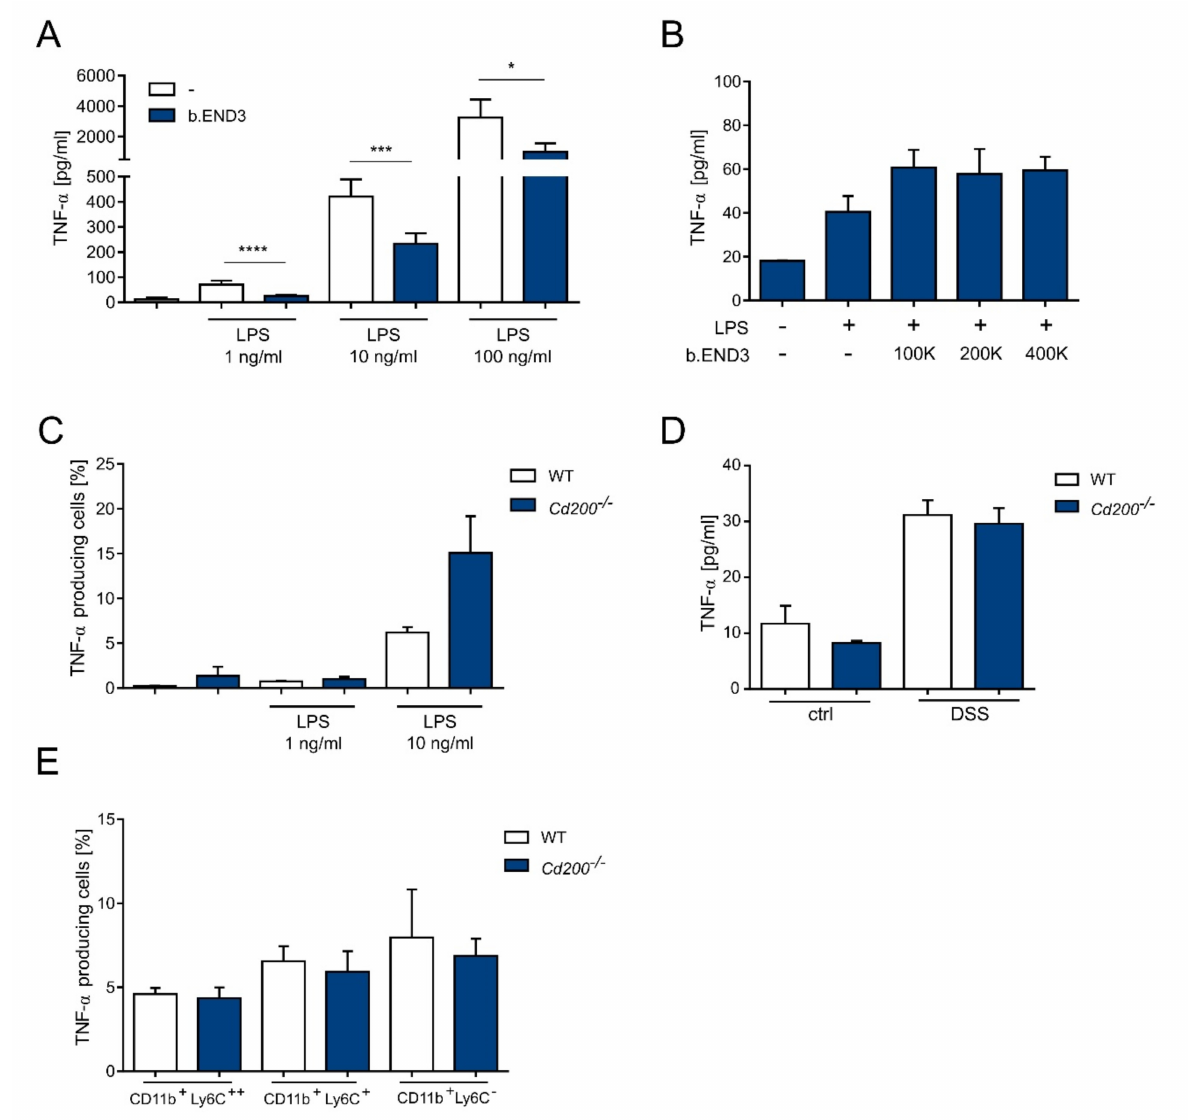
Figure 6. Production of TNF- α by BMDMs and colon tissue in the presence or absence of CD200 expression. ( A ) The concentration of TNF- α was measured in the supernatants from the co-culture of WT BMDMs and b.END3 cells after 24 h of incubation with or without 1–100 ng/mL LPS, n = 4–6; ( B ) The concentration of TNF- α was measured in the supernatants from 24-h co-cultures of WT BMDMs and indicated a number of b.END3 cells with or without 1 ng/mL of LPS without direct contact of two populations (Transwell system), n = 2–3; ( C ) Percentage of TNF- α + WT or Cd200 − / − BMDMs after 4 h incubation with 1 or 10 ng/mL LPS, n = 3. ( D ) The concentration of TNF- α in medium from 24 h culture of colon explants isolated from control or DSS-treated WT and Cd200 − / − mice, n = 8–13; ( E ) Percentage of TNF- α + myeloid cells: CD11b + Ly6C ++ , CD11b + Ly6C + and CD11b + Ly6C − in colons of DSS-treated WT and Cd200 − / − mice, n = 6–9. Results are expressed as mean ± SEM. Significant differences were calculated using Student’s t -test * p < 0.05. *** p < 0.001. **** p <